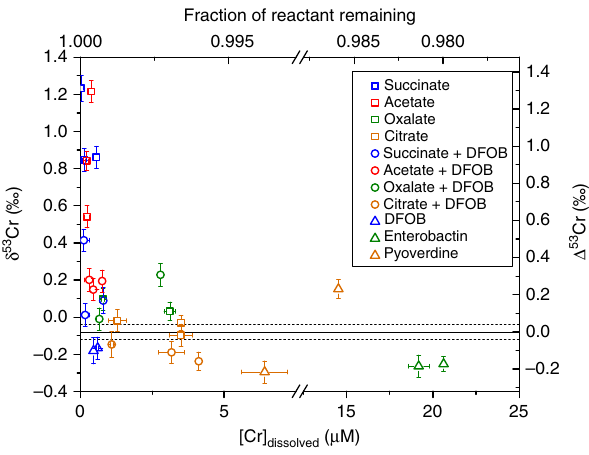
Fig. 3 Cr isotope composition. δ 53 Cr as a function of reaction extent (either fraction of reactant remaining or concentration of Cr dissolved) for each ligand or ligand combination. Δ 53 Cr represents δ 53 Cr solution − δ 53 Cr initial solid at distinct points during dissolution. The isotopic signature of the starting solid is represented by the solid line at δ 53 Cr = − 0.08 ‰ and Δ 53 Cr = 0. The dashed lines represent ± 2 σ (analytical measurement reproducibility). Experimental conditions are 0.2 g l − 1 of Cr(OH) 3 at pH 7 (10 mM HEPES) and ionic strength of 0.1 M